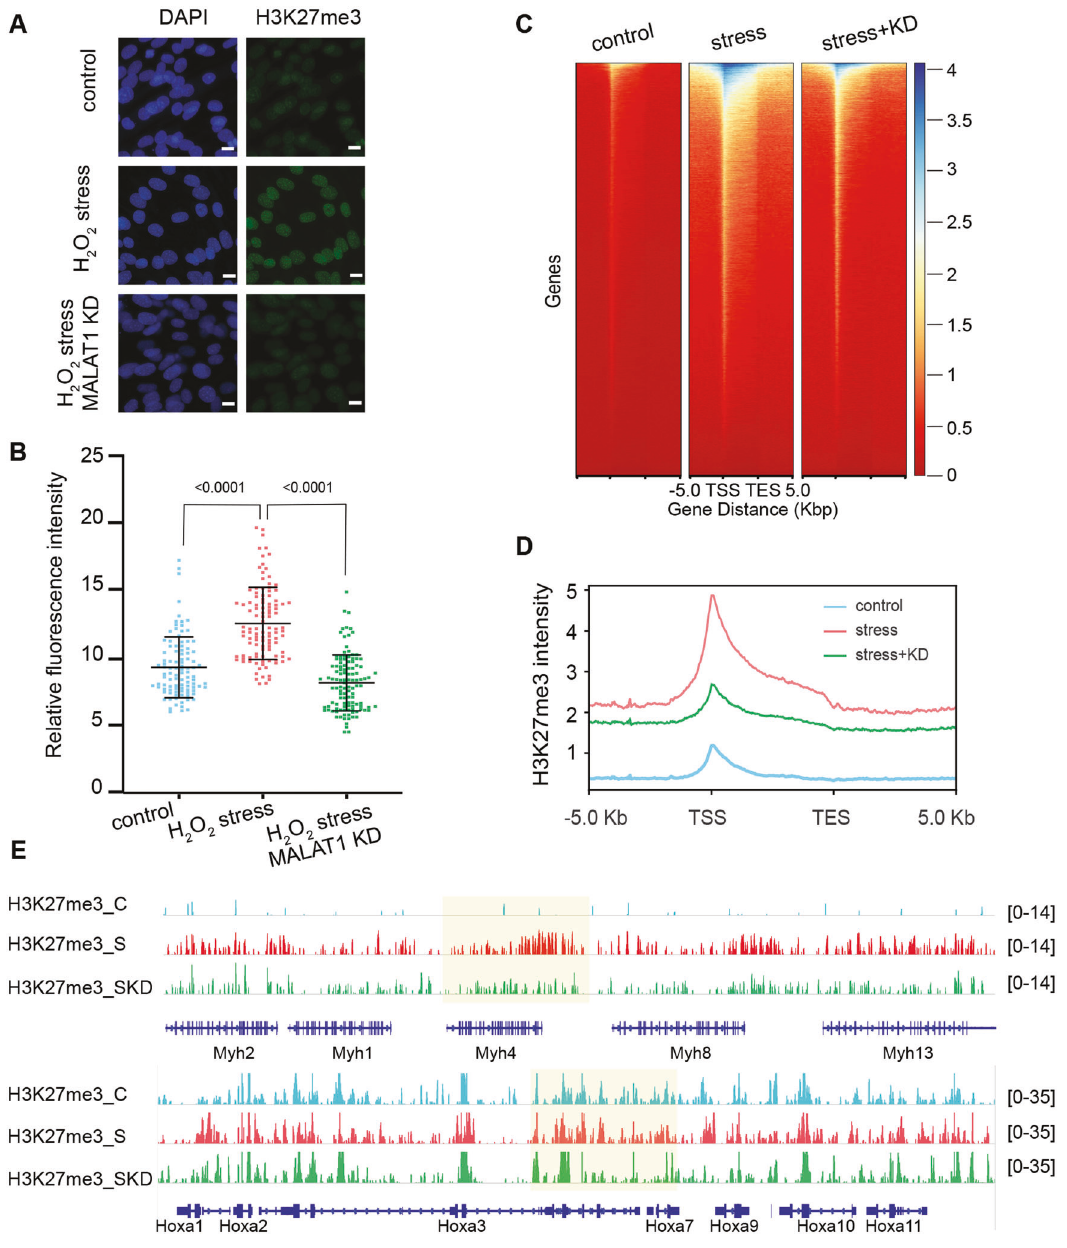
Fig. 2 Global H3K27me3 stress-induced enrichment is compromised by Malat-1 depletion. A , B Immunostaining of H3K27me3 (green) under indicated condition, nuclei are stained with DAPI (blue), scale bar = 10 μ m ( A ). Relative H3K27me3 fl uorescence intensity was graphed ( B ). Minimum 100 nuclei were counted for statistical analysis. P -value shown on top of each graph using the t -tests. C , D ChIP-seq analysis of H3K27me3 landscape under normal, stress, and stress upon Malat1 depletion conidiations. Heatmap ( C ) and metagene pro fi les ( D ) of H3K27me3 abundancy centered at gene body loci (±5 kb) for all genes under different indicated conditions. E , F IGV browser views of H3K27me3 pro fi les deposited around myosin heavy chain (MYH) gene clusters ( E ) and Hoxa gene clusters ( F ). All track signals have been normalized over spike-in control and input. H3K27me3_C, H3K27me3_S, and H3K27me3_SKD indicate H3K27me3 ChIP-seq signal under normal, stress, and stress with Malat1 depletion condition,